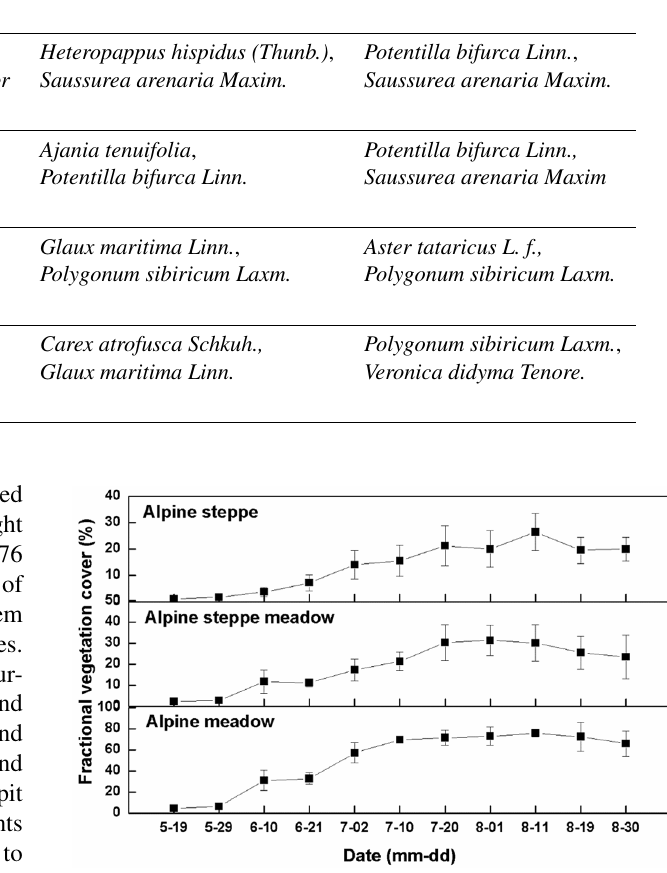
Figure 2. Seasonal variations in fractional vegetation cover during 19 May–30 August 2012 on alpine steppe, alpine steppe meadow, and alpine meadow grasslands of the Shule River